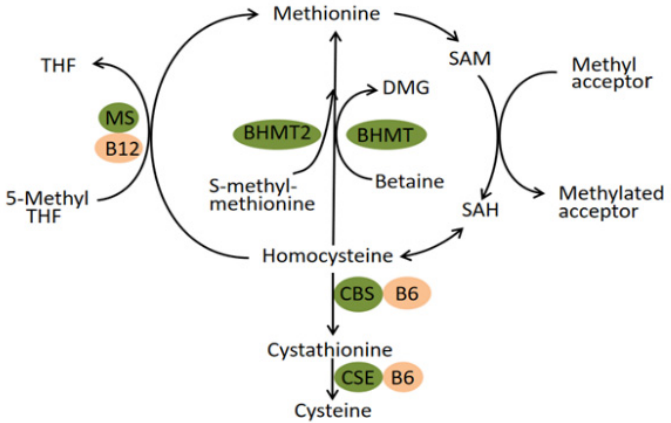
Figure 1. Pathways of homocysteine metabolism. Abbreviation: BHMT Betaine-homocysteine S-methyltransferase; MS methionine synthase; CBS cystathionine β -synthase; CSE cystathionine- γ -lyase; THF tetrahydrofolate; DMG dimethylglycine; SAM S-adenosylmethionine; SAH S-adenosylhomo- cysteine.